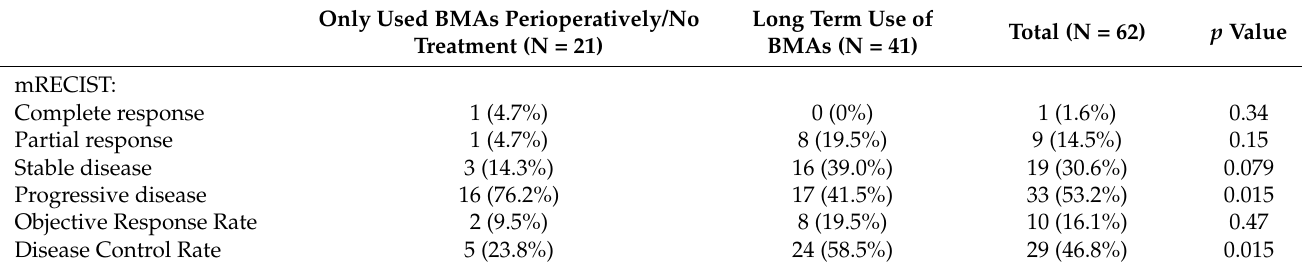
Table 4. Best response of BMA-related treatment, N = 62